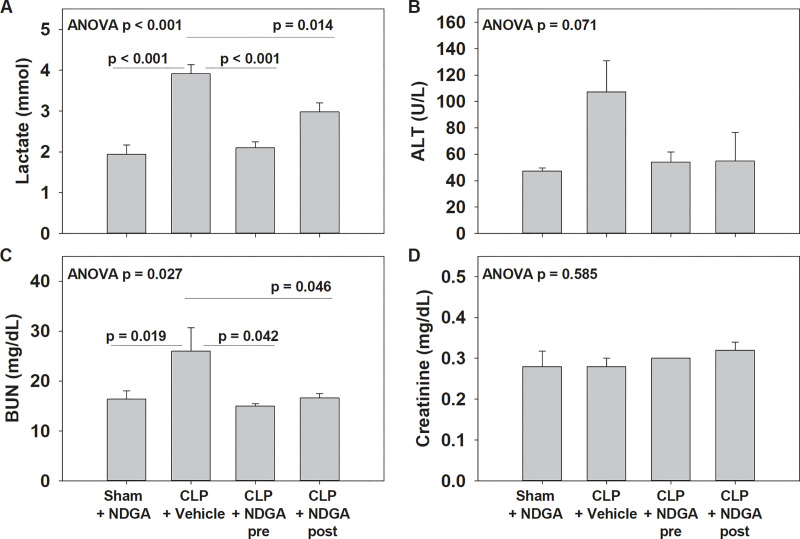
Quantification of metabolic status, liver injury, and kidney injury.(A) Quantification of tissue elevations in lactate to quantify derangements in acid base status and sepsis severity (n = 5 in each group). Significant reduction in serum lactate were seen among groups given NDGA both before and 6h after CLP when compared with CLP animals; (B) Quantification of ALT as a marker of liver injury. No differences were seen between groups; (C,D) Quantification of serum BUN and Cr as measures in kidney injury. Among BUN, significant reductions were seen among the sham group and groups given NDGA both before and 6h after CLP when compared with CLP animals. No differences were seen among Cr between the groups.